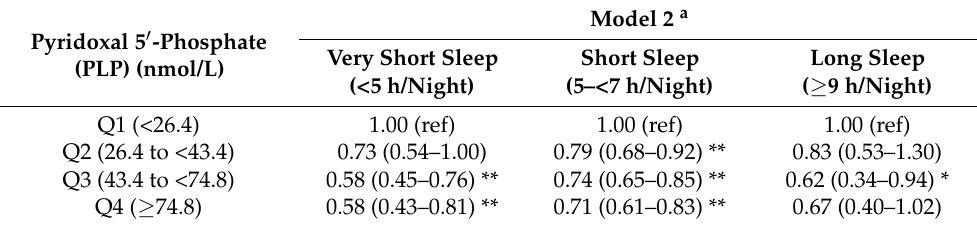
quartiles of pyridoxal 5 (cid:48) -phosphate (PLP) concentrations (NHANES